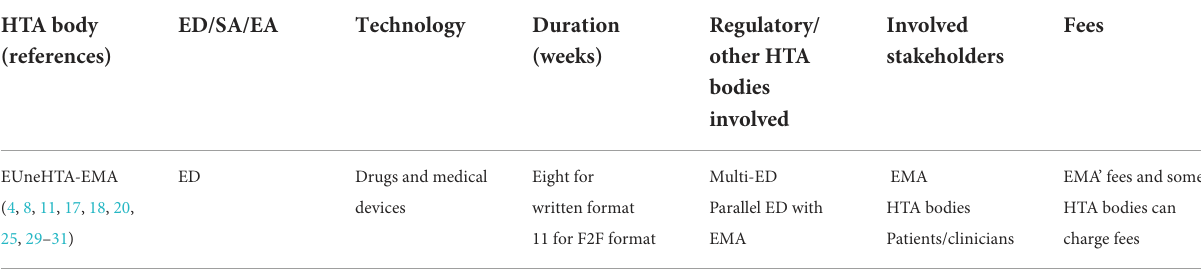
TABLE 2 Early dialogue/joint advice services by EUnetHTA and